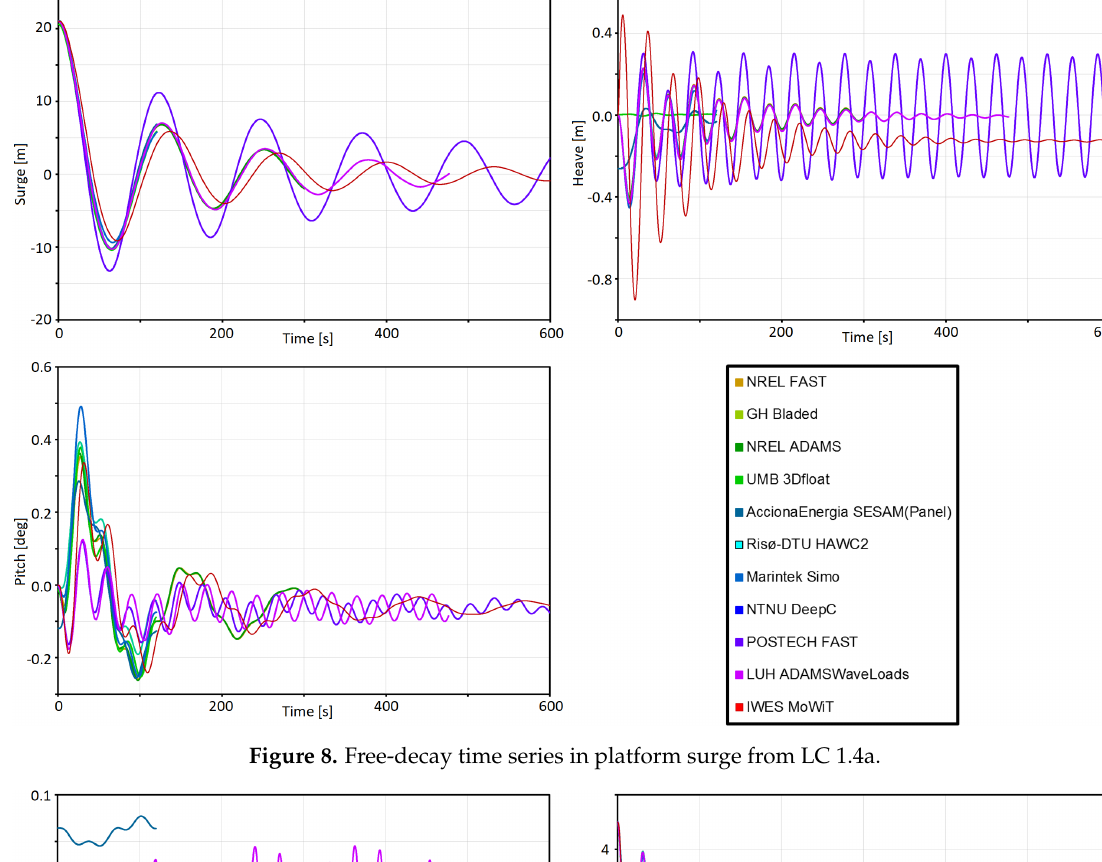
Figure 8. Free-decay time series in platform surge from LC 1.4a.